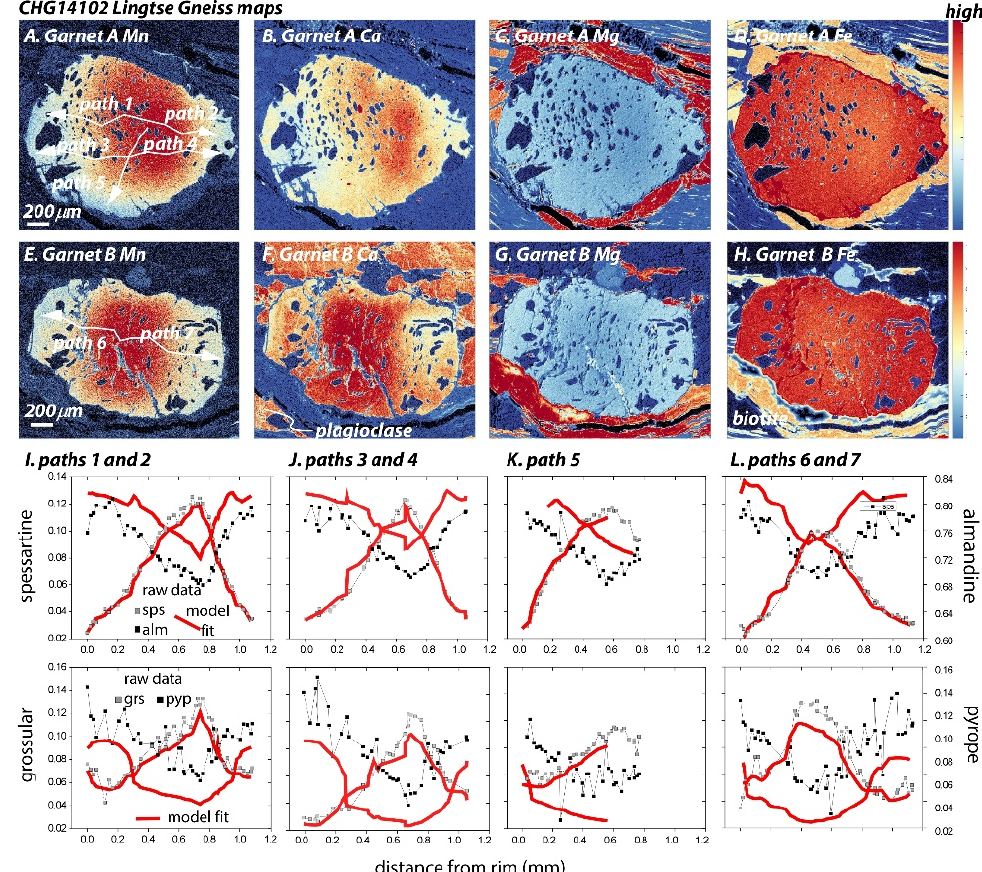
Figure 5. X-ray element maps of sample CHG14102 (Lingtse Gneiss) in ( A ) and ( E ) Mn, ( B ) and ( F ) Ca, ( C ) and ( G ) Mg, and ( D ) and ( H ) Fe. Garnet compositions in spessartine (sps) and almandine (alm) ( upper panels I – L ) and grossular (grs) and pyrope (pyp) ( lower panels I – L ) were taken across the rim to rim transects identified in panels ( A , E ). The red lines in panels ( I – L ) show the prediction of the high-resolution P-T paths generated for this sample.